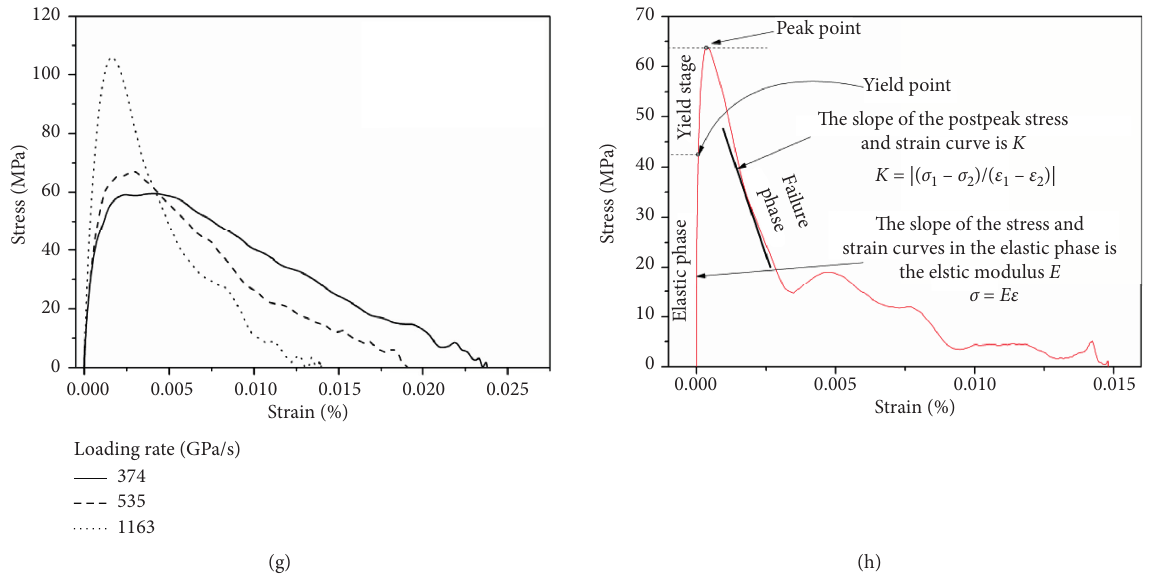
Figure 5: Stress and strain under three different types of loading rates: 200 to 400GPa/s, 400 to 600GPa/s, and above 600GPa/s. (a–g) The inclination angles of 0 ° , 15 ° , 30 ° , 45 ° , 60 ° , 75 ° , and 90 ° , respectively; h is the schematic diagram of E and K